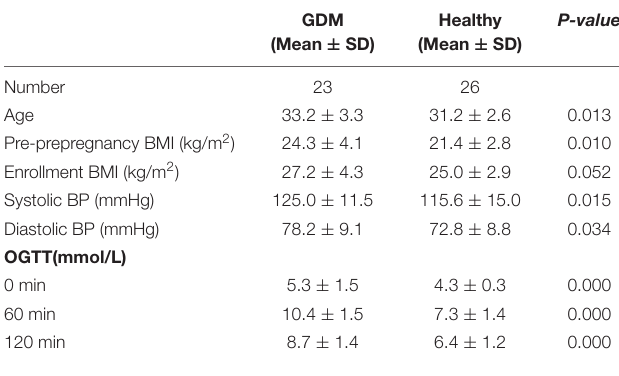
TABLE 1 | The clinical characteristics of 23 GDM patients and 26 healthy